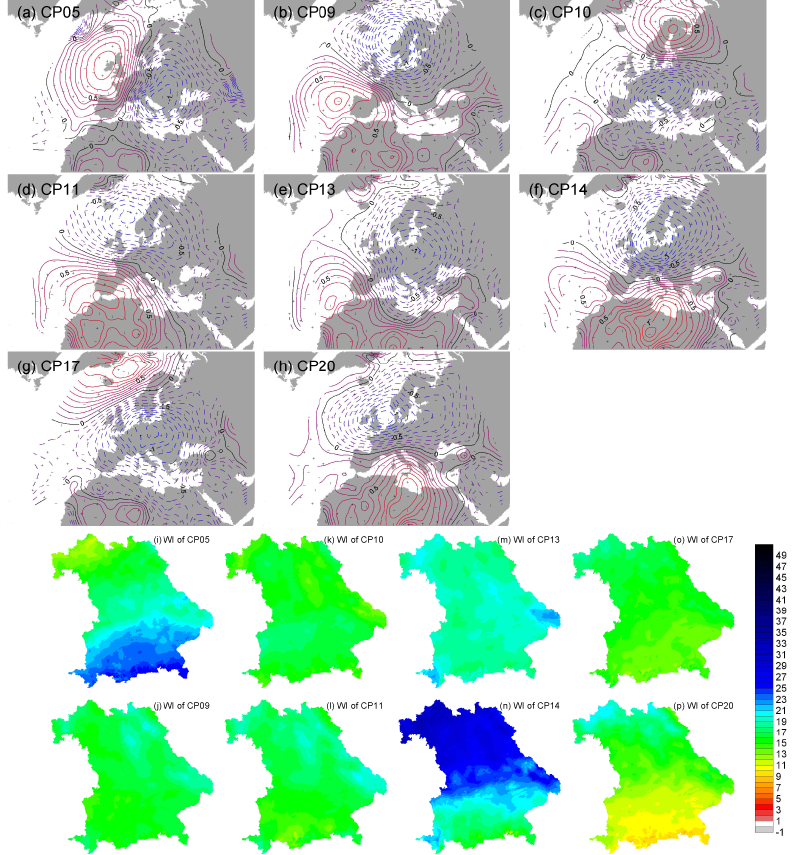
Fig. 4. Geopotential anomalies and wetness index of wet CPs for